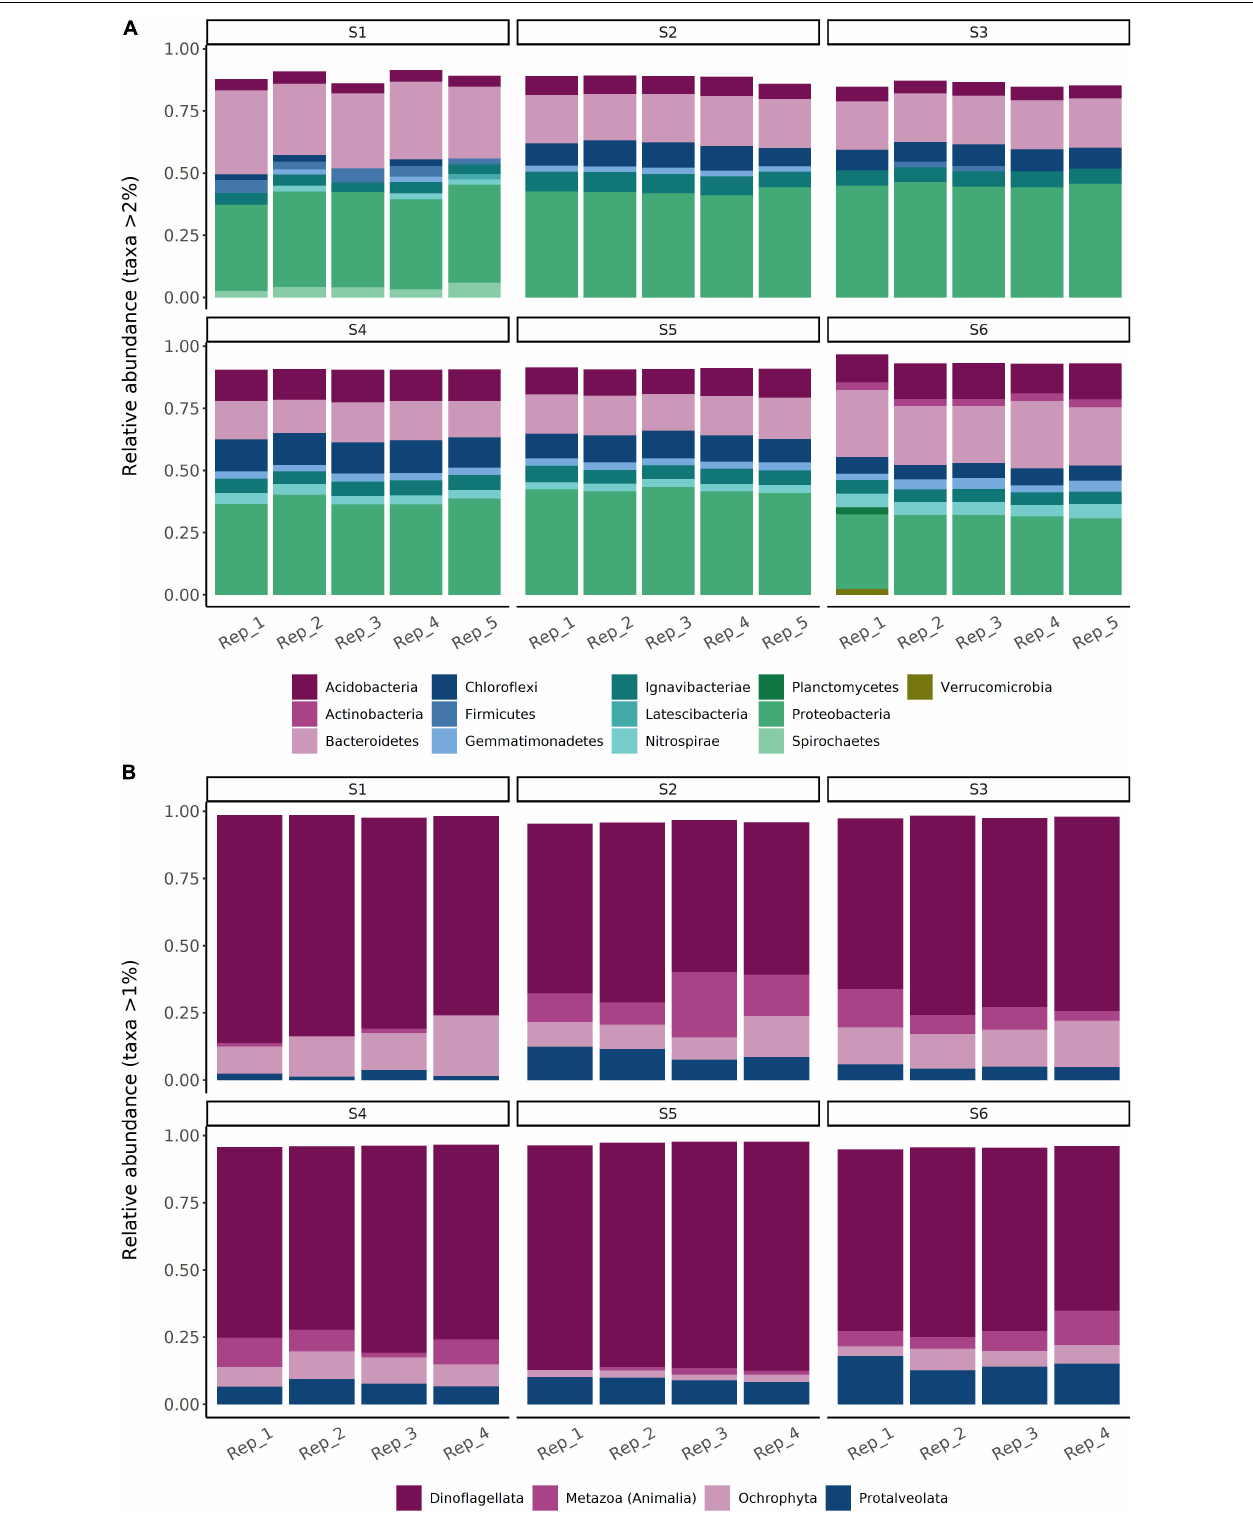
FIGURE 4 | Overall relative abundances (%) of (A) bacterial and (B) eukaryotic operational taxonomic units (OTUs) within sediment samples collected from a total of six sampling sites in the Archipelago Sea (Baltic Sea). Bacterial data are shown at the phylum level. Eukaryotic data are shown at the Rank 4 level of the SILVA 132 majority taxonomy mapping file with seven taxonomic levels (comprising multiple levels of taxonomic